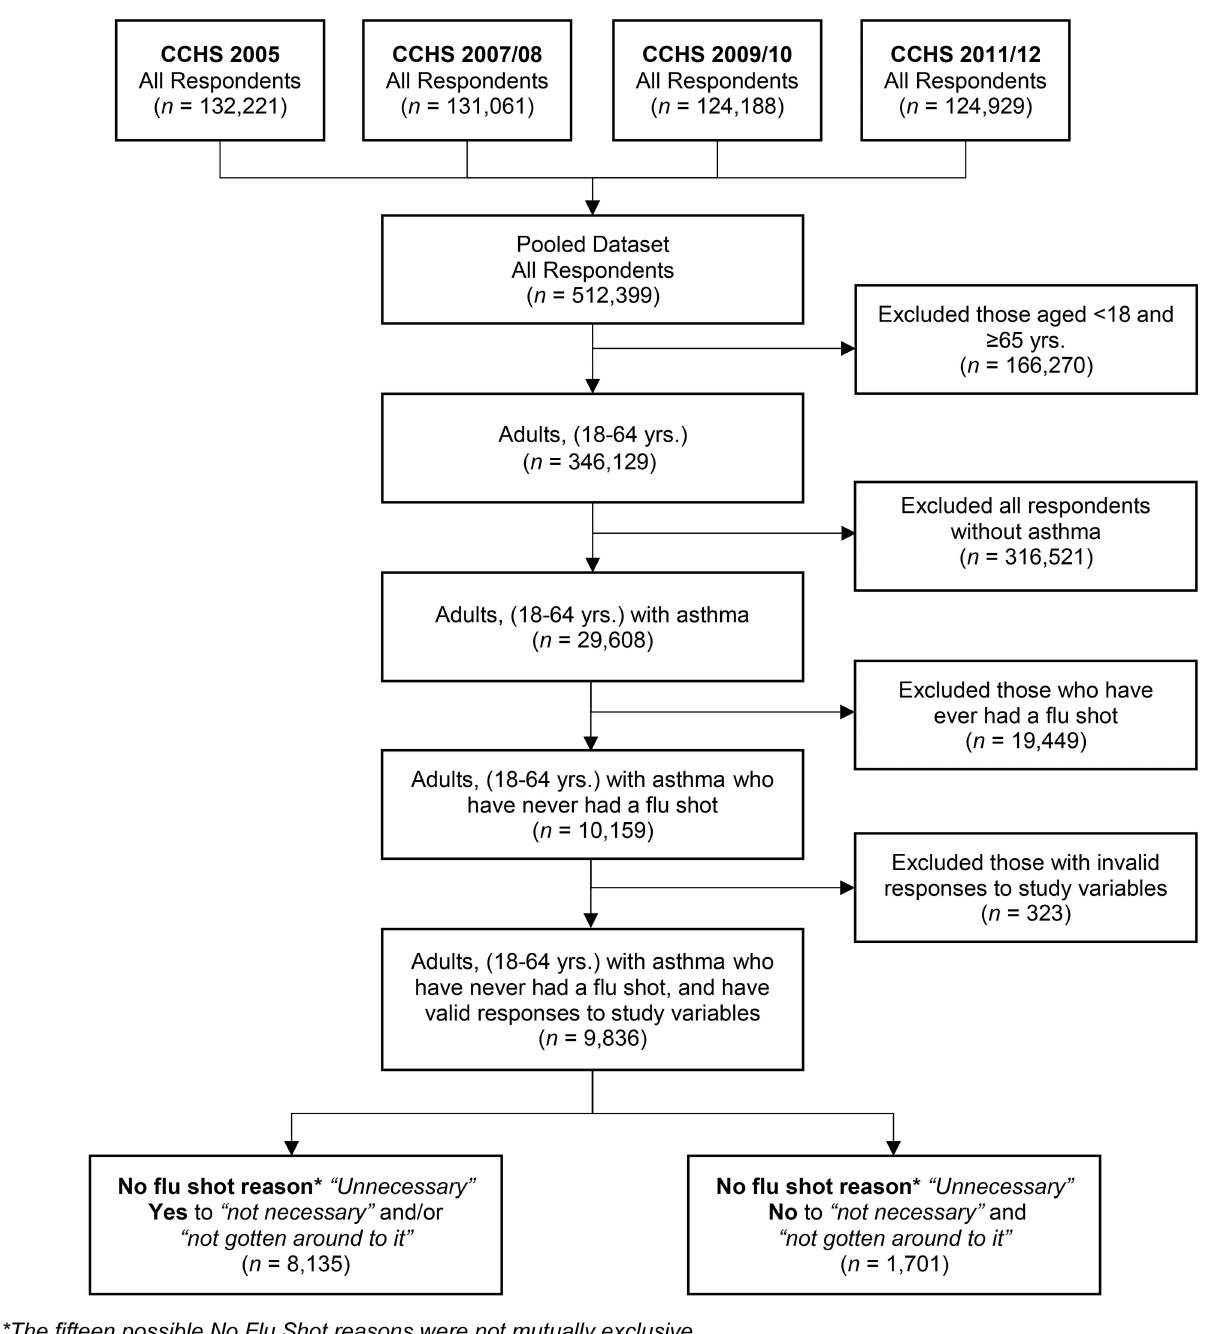
Fig 1. Analytic sample. Selection of the final analytic sample, examiningthe association betweenself-reportedhealth and the reasonsfor non-vaccination againstseasonalinfluenza amongCanadianadults with asthma, using pooledCCHS cycles 3.1(2005), 2007/08, 2009/10, 2011/12. Invalidresponsesincluded don’t know , refusal , and not stated